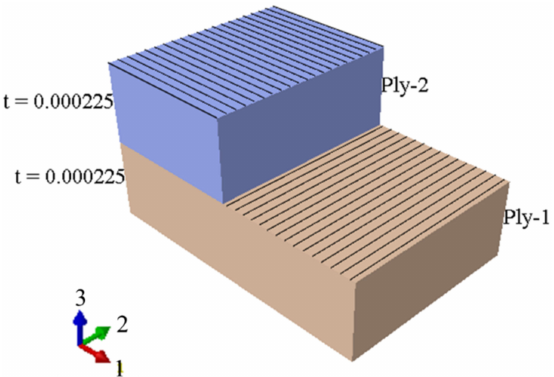
Figure 2. The schematic of the simulated laminate, comprising two plies.